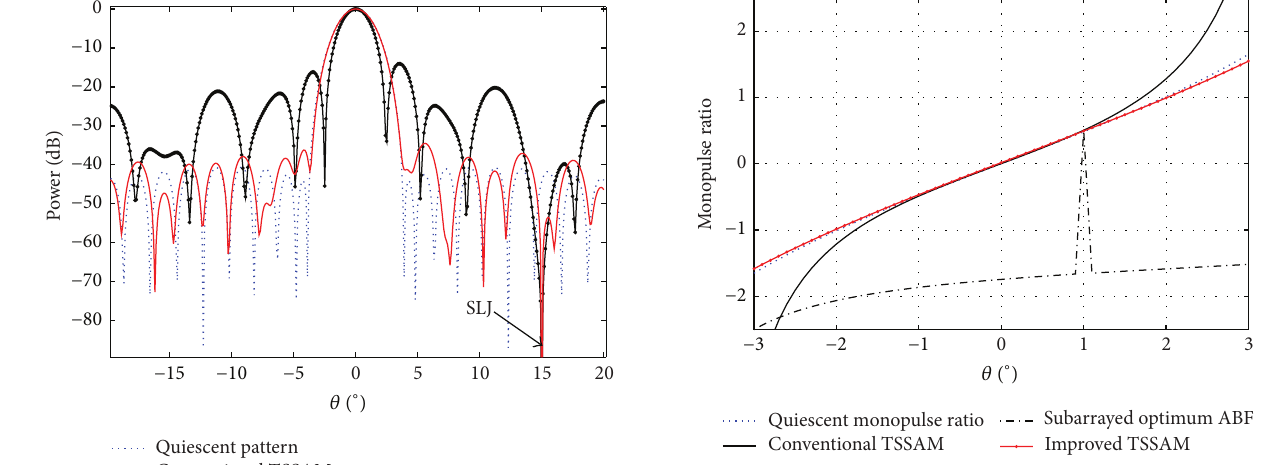
Figure 17: Elevation monopulse ratio obtained by two-stage adap- tive